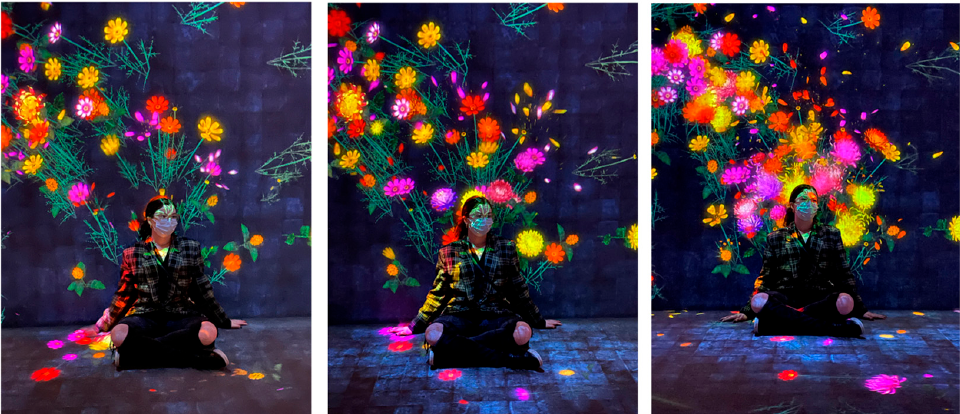
Figure 13. teamLab, Forest of Flowers and People: Lost, Immersed and Reborn (slow growing), 2017/2021, Asian Art Museum of San Francisco; photograph by the author, 2022.